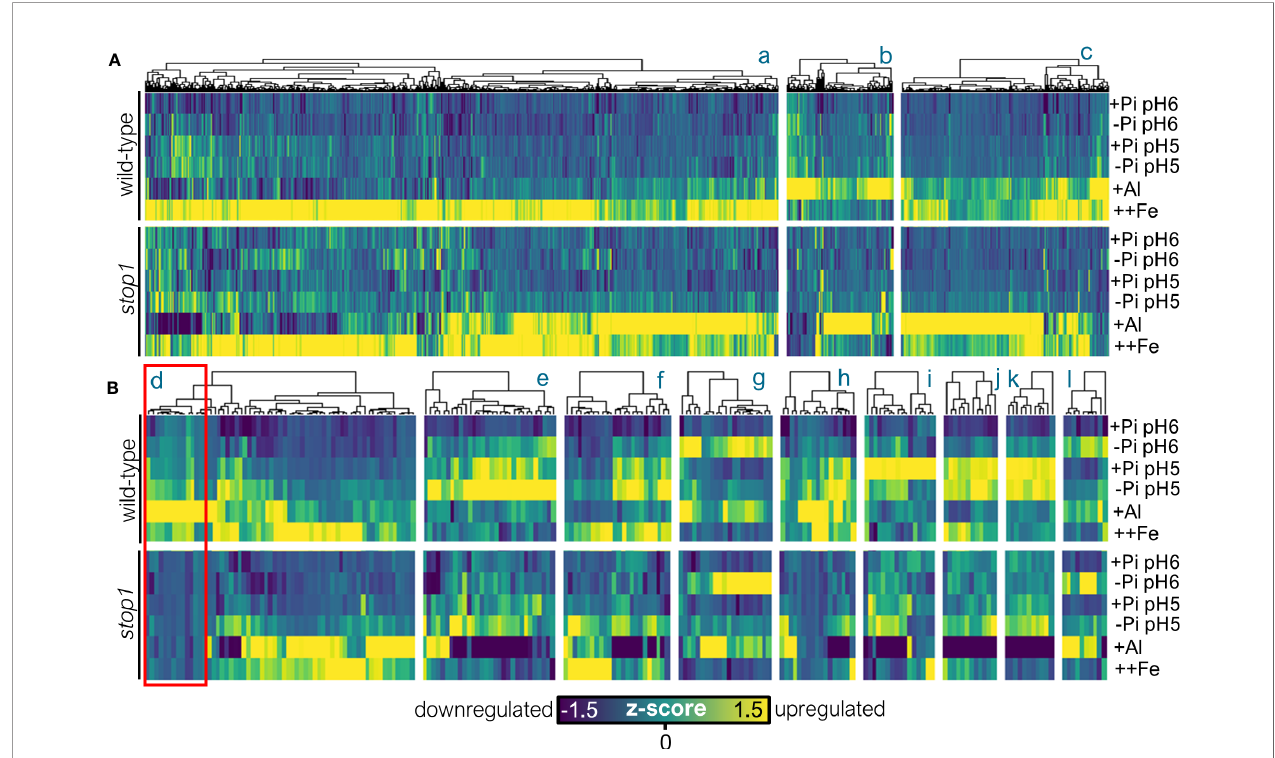
FIGURE 3 | STOP1 has a major effect on the transcriptome landscape in response to low Pi, low pH and Al exposure conditions. (A) Upper panel: heatmap of normalized gene expression (z-score) in the roots of wild-type seedlings exposed to the indicated treatment. Differentially upregulated genes (FDR <.05) from upregulated subsets a-c (obtained from Figure 2 ) are presented and clustered using the Pearson method. Lower panel: heatmap of normalized gene expression (z-score) in the roots of stop1 seedlings exposed to the indicated treatment. Differentially upregulated genes (FDR <.05) from upregulated subsets a-c (obtained from Figure 2 ) are presented and clustered using the Pearson method. The subsets a-c were obtained from the Venn analysis presented in Figure 2A , these are the stress-interaction or stress- speci fi c subsets of genes upregulated in response to the tested treatments and have the same letter identi fi ers as in Figure 2A . (B) Upper panel: heatmap of normalized gene expression (z-score) in the roots of wild-type seedlings exposed to the indicated treatment. Differentially upregulated genes (FDR <.05) from upregulated subsets d-l (from Figure 2 ) are presented and clustered using the Pearson method. Lower panel: heatmap of normalized gene expression (z-score) in the roots of stop1 seedlings exposed to the indicated treatment. Differentially upregulated genes (FDR <.05) from upregulated subsets d-l (obtained from Figure 2 ) are presented and clustered using the Pearson method. The subsets d-l were obtained from the Venn analysis presented in Figure 2A , these are the stress-interaction or stress-speci fi c subsets of genes upregulated in response to the tested treatments and have the same letter identi fi ers as in Figure 2A